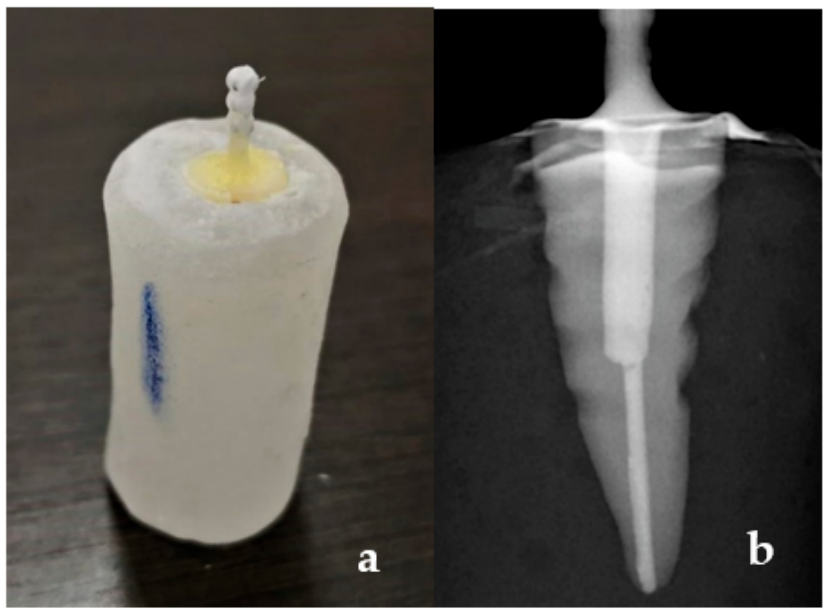
Figure 3. ( a ) Cemented fiber post; ( b ) Radiograph after the cementation of post.